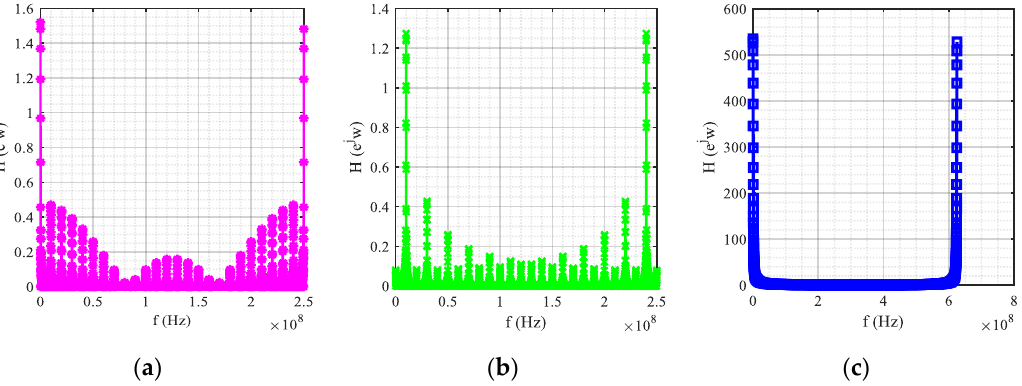
Figure 2. The energy distribution on the frequency of excitation. ( a ) Square wave ( f = 10 7 Hz, duty cycle = 0.1). ( b ) Square wave ( f = 10 7 Hz, duty cycle = 0.5). ( c ) Experimental turn-off signal.